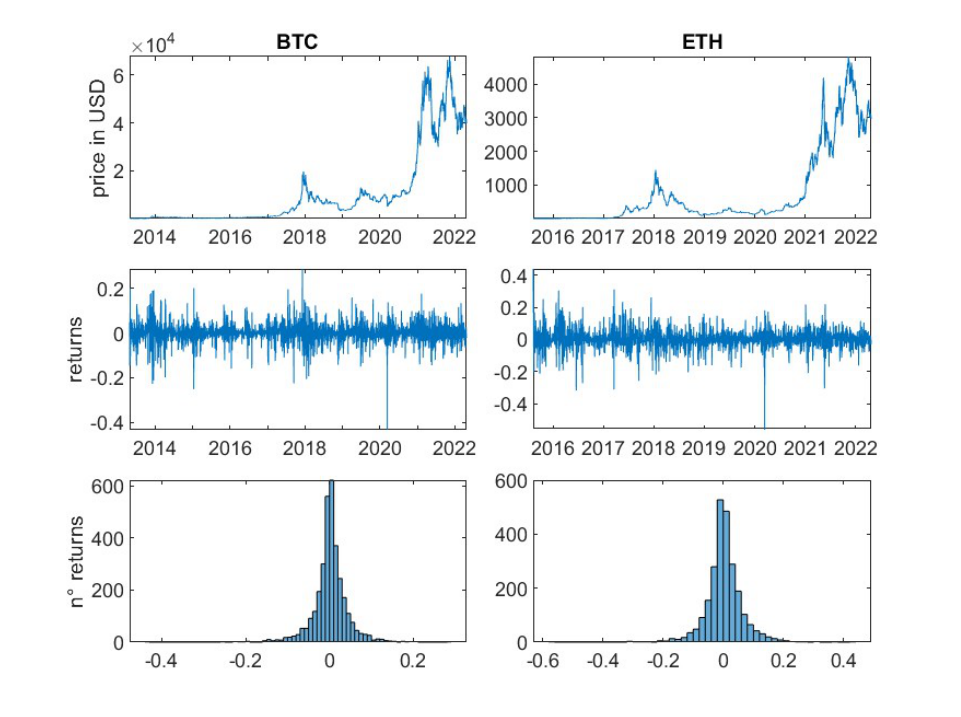
Figure A1. BTC and ETH daily logarithmic